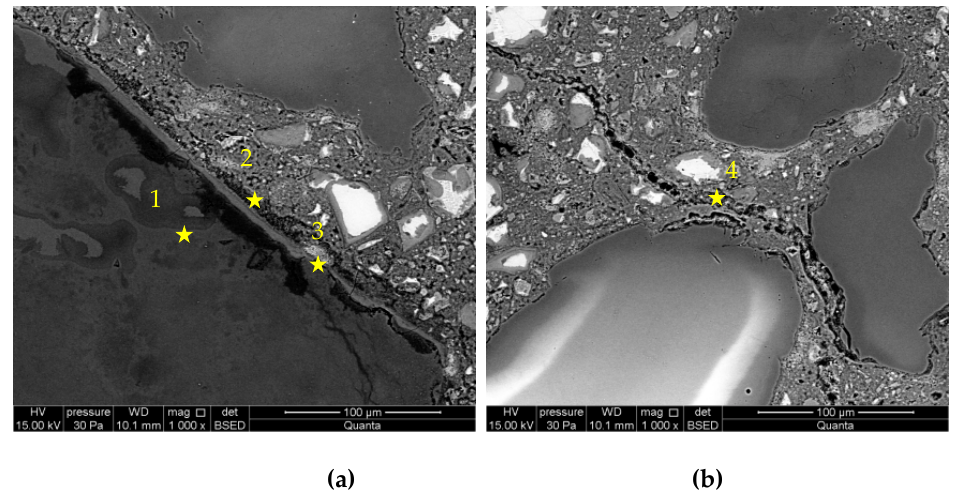
Figure 9. Microstructure images of mortars with metakaolin and lithium nitrate in 5% of metakaolin and [Li/Na + K] = 0.74 samples: ( a ) ASR gel in aggregate and ITZ; ( b ) ASR gel in cement paste. X-ray microanalysis at location 1 – 4 (see Table 4).